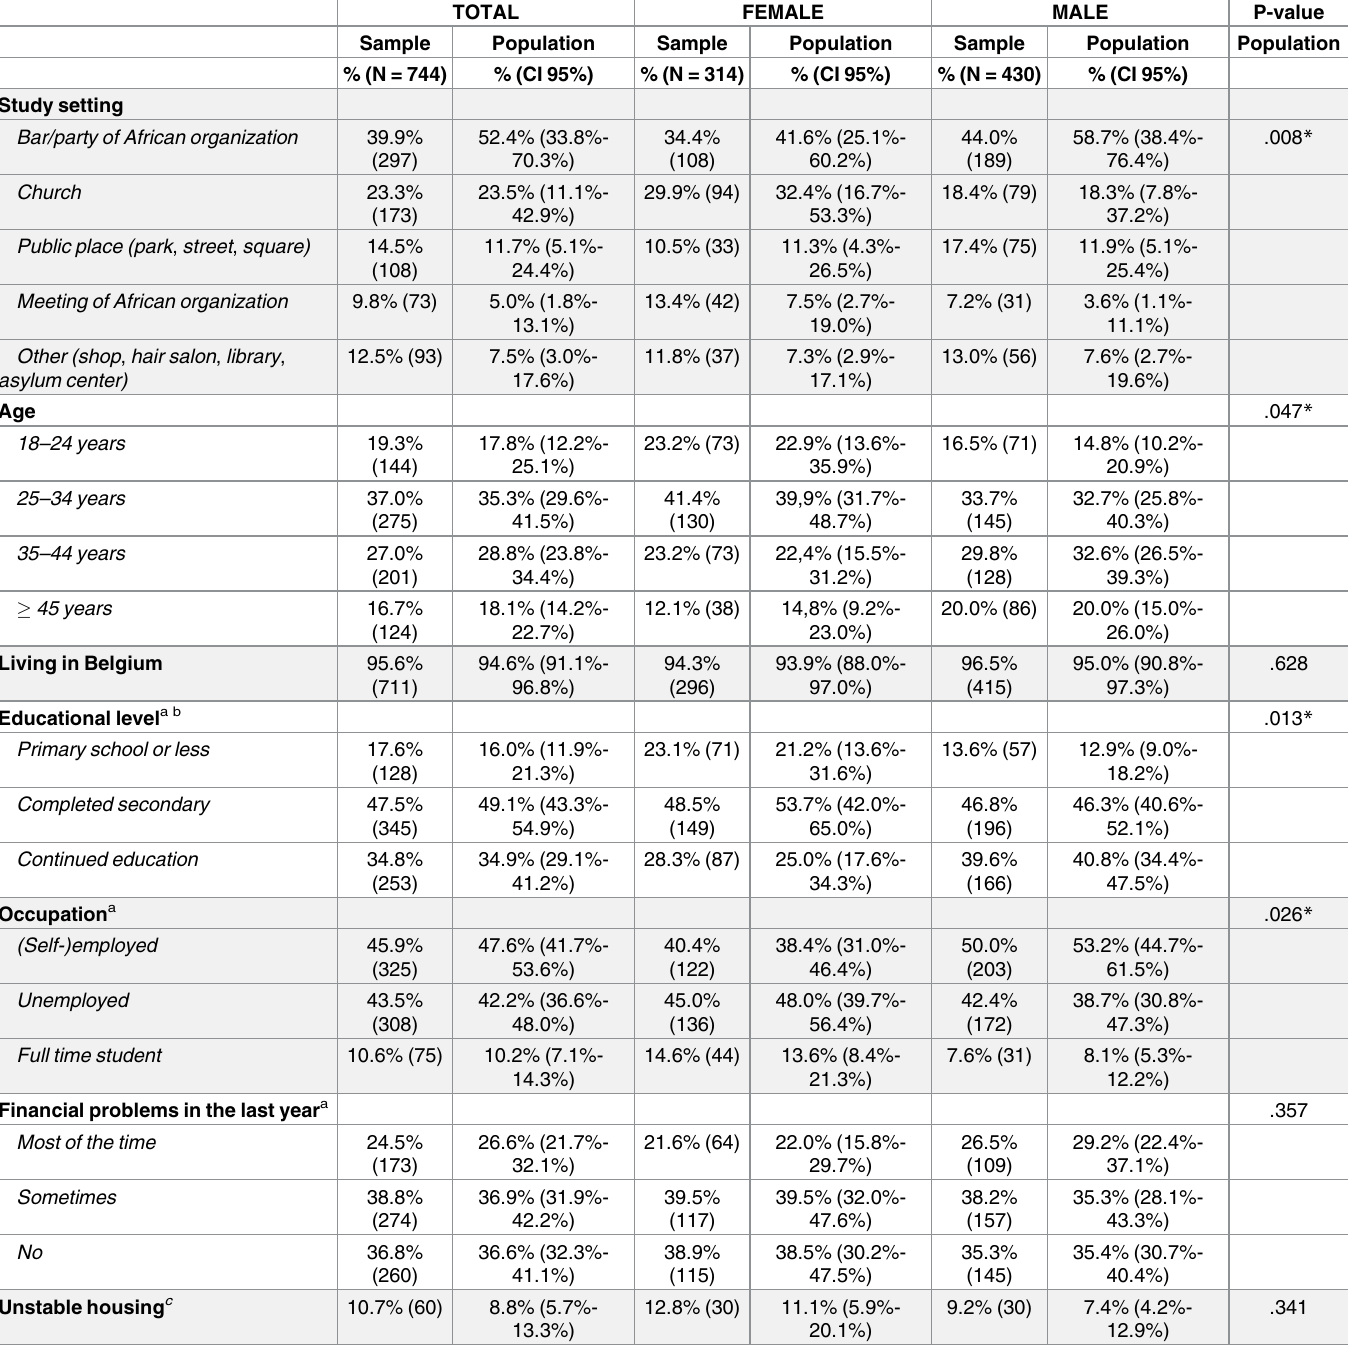
Table 1. Socio- demographic characteristics of the sample (unweighted) and population estimates of sub-Saharan African migrants socializing in Antwerp city (weighted), stratified by